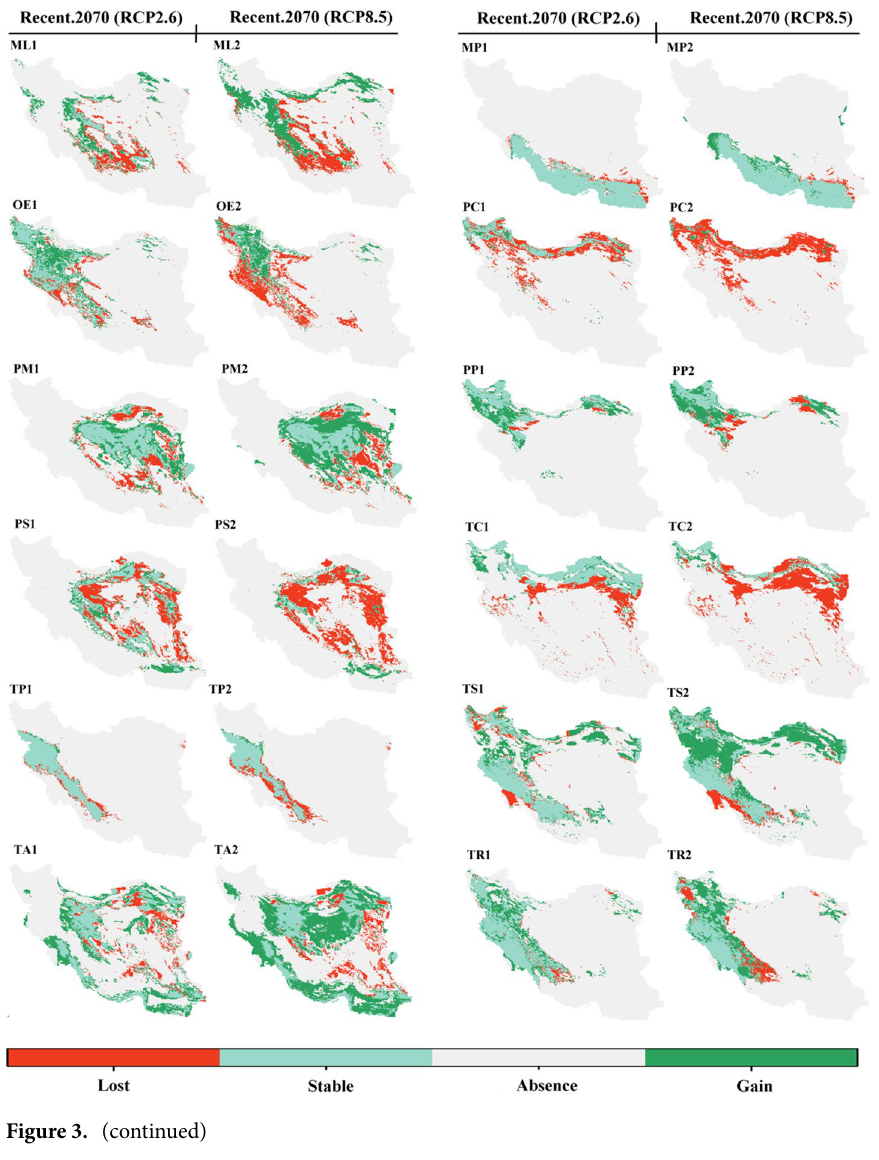
Figure 3. mountains in higher latitudes (Fig. 2 ML2 and ML3 and Fig. 3 ML1 and ML2). According to both scenarios, especially RCP8.5, habitat loss will occur in the eastern and southern parts of the distribution range, especially at low latitudes (Fig. 3 ML1 and ML2). Based on the consensus model under RCP2.6 and RCP8.5, habitat loss was estimated at 58.74% and 92.84%, and new habitat gain at 60.15% and 122.23%, respectively (Table 3). M. persicus (MP). BIO15 (50.85%) and BIO1 (29.24%) are the two important variables affecting the distri- bution of Persian Tiny Gecko, respectively (Table 2). The habitat suitability map for recent climate conditions shows that the southwest, south, and southeast of Iran have 50 to 100% (especially 75–100%) suitability (Fig. 2 HF1). Based on future climate change (especially RCP8.5), suitable habitats, in addition to maintaining the recent range, will expand to higher latitudes in the northern margins of the southern and southwestern ranges. Expansion onto the Mesopotamian plain is also apparent, especially in RCP8.5 (Fig. 2 MP2 and MP3 and Fig. 3 MP1 and MP2). According to RCP8.5, habitat loss will occur in the northern margins of the southeastern range (Fig. 3 MP1 and MP2). Based on the consensus model under RCP2.6 and RCP8.5, habitat loss was estimated at 9.20% and 5.23%, and new habitat gain at 2.47% and 18.31%, respectively (Table 3). O. elegans (OE). BIO12 (39.50%) and BIO14 (17.69%) are the two important variables affecting the distri- bution of Elegant Snake-eyed Lizard, respectively (Table 2). The habitat suitability map for recent climate condi- tions shows that the northwestern, western, and southwestern parts of the country around and along the Zagros range, the Mesopotamian plain, the southern Alborz, a part of the Kopet Dagh mountains, and the southern Iranian plateau have 50 to 100% suitability (Fig. 2 OE1). Based on future climate change in the RCP2.6, suitable habitats (especially 75–100%), in addition to maintaining the recent range, will expand to the northwestern